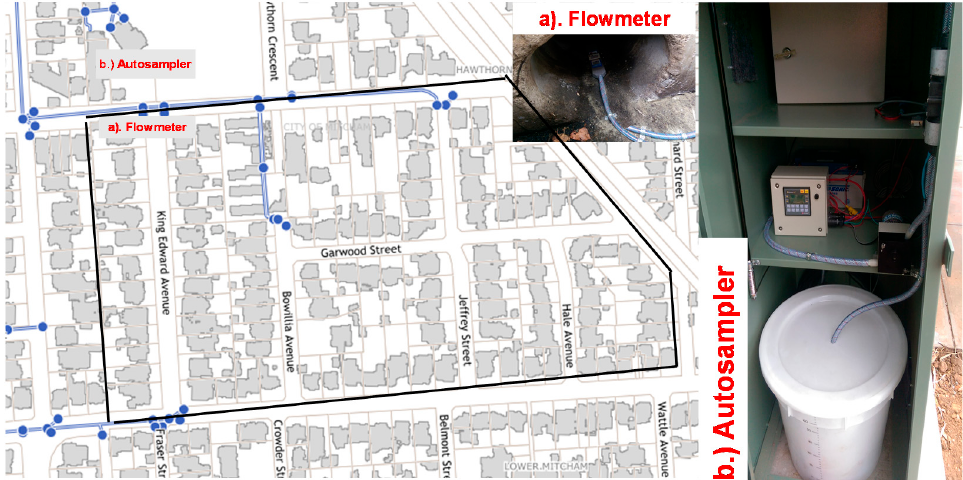
Figure 2. The case study catchment with drainage network is shown. The extent of the catchment boundary is highlighted and inset. ( a ) The flowmeter installed at the end of catchment outlet pipe and ( b ) the automated water sampler enclosed in a cabinet.